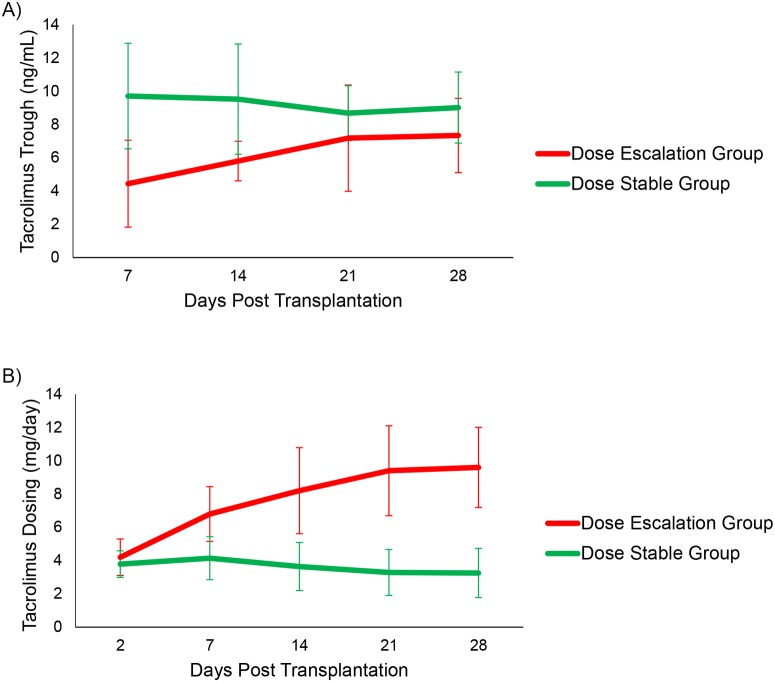
Tacrolimus Trough Levels and Tacrolimus Dosing in the Kidney Transplant Cohort.A) Tacrolimus troughs are shown over the course of the first month. On the x-axis is the day after kidney transplantation and on the y-axis is the mean tacrolimus trough of the group (ng/mL) corresponding to the day on the x-axis. The Dose Escalation Group is represented by the red line with corresponding standard deviation bars and the Dose Stable Group is represented by the green line with corresponding standard deviation bars. P values at each time point were calculated using a two-way between-group ANOVA using contrasts to evaluate the two groups at each time point and is listed above each time point. B) Tacrolimus dosing is shown over the course of the first month. On the x-axis is the day after kidney transplantation and on the y-axis is the mean tacrolimus dosing of the group (mg/day) corresponding to the day on the x-axis. The Dose Escalation Group is represented by the red line with corresponding standard deviation bars and the Dose Stable Group is represented by the green line with corresponding standard deviation bars. P values at each time point were calculated using a two-way between-group ANOVA using contrasts to evaluate the two groups at each time point and is listed above each time point.